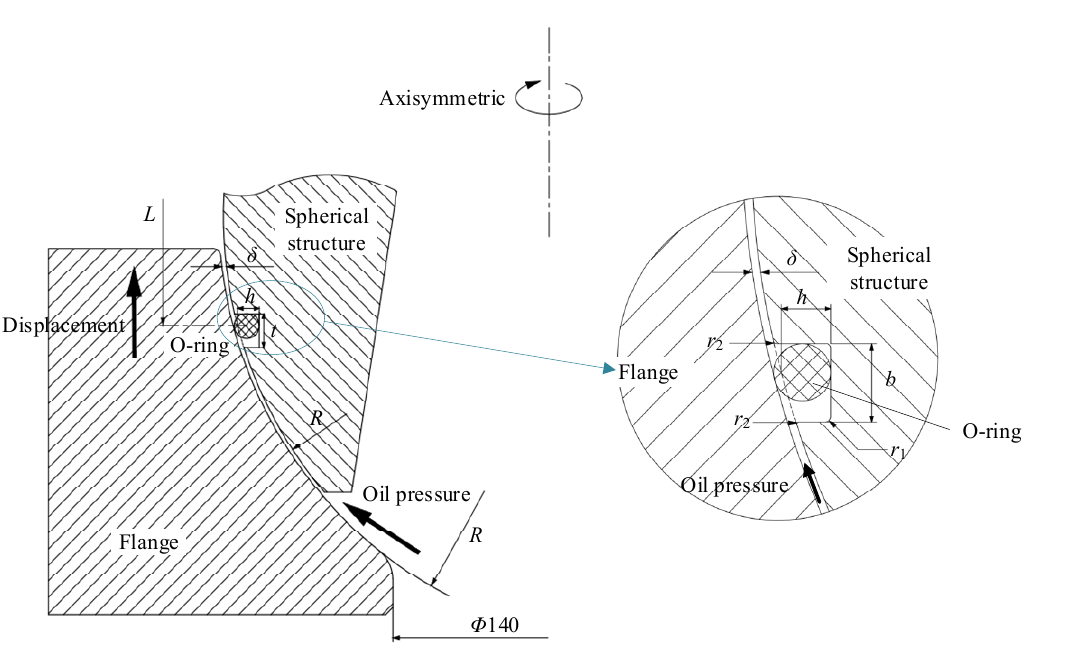
Figure 6. Diagram of O-ring sealing groove structure.